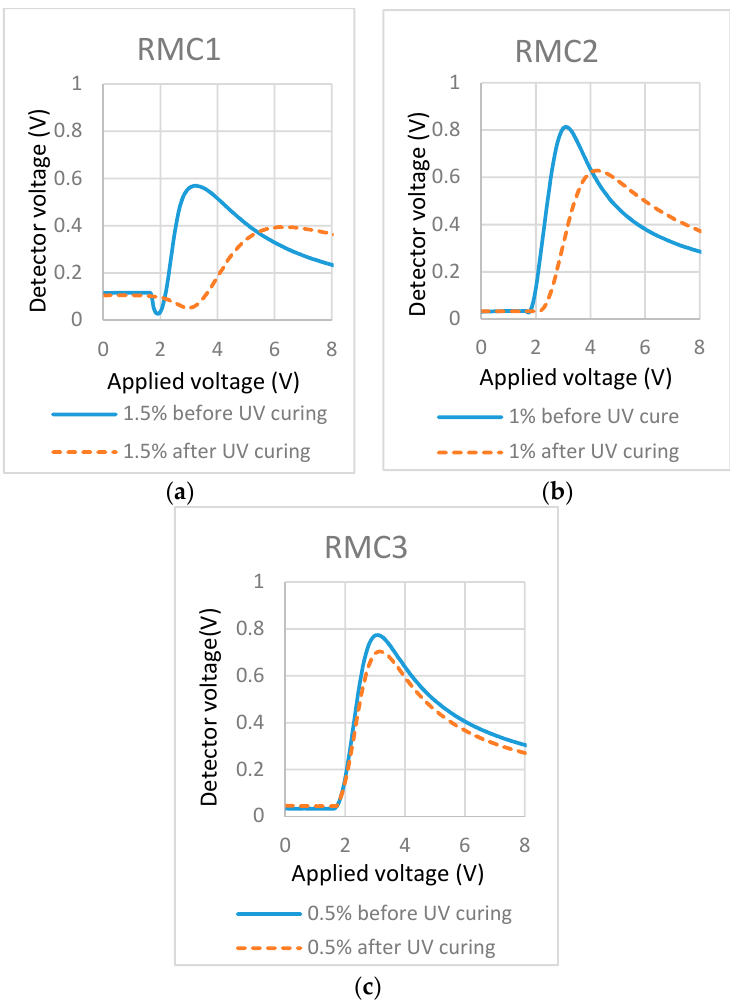
Figure 3. Transmission-applied voltage curves of cells filled with mixtures of different concentrations of RM in LC. ( a ) 1.5% Bis-MA in LC; ( b ) 1% Bis-MA in LC; and ( c ) 0.5% Bis-MA in LC.